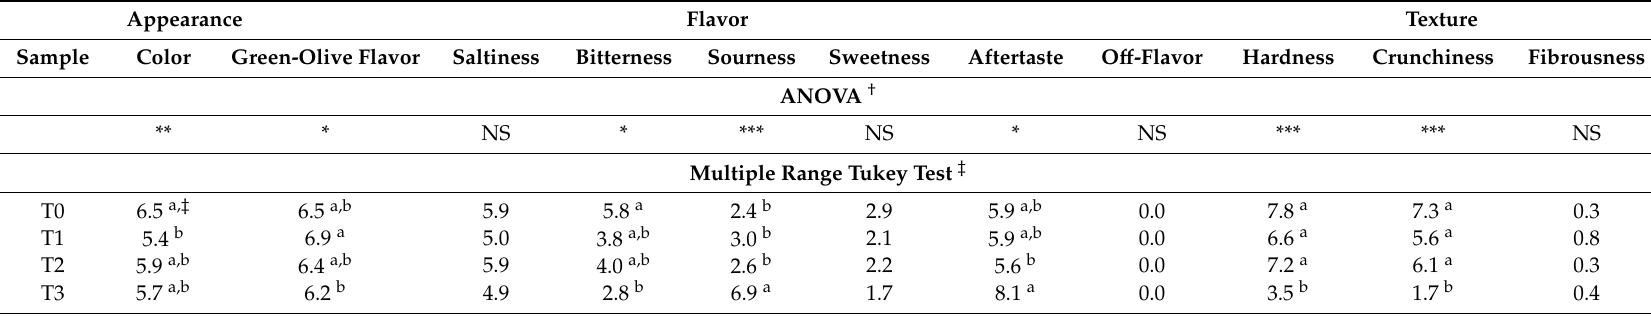
Table 3. Descriptive sensory attributes of table olives as a ff ected by the irrigation treatment. Scale used ranged from 0 = no intensity to 10 = extremely strong intensity. Appearance Flavor Texture Sample Color Green-Olive Flavor Saltiness Bitterness Sourness Sweetness Aftertaste O ff -Flavor Hardness Crunchiness Fibrousness ANOVA †